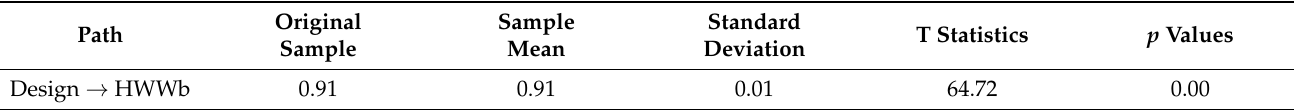
Table 11. Path Coefficient.